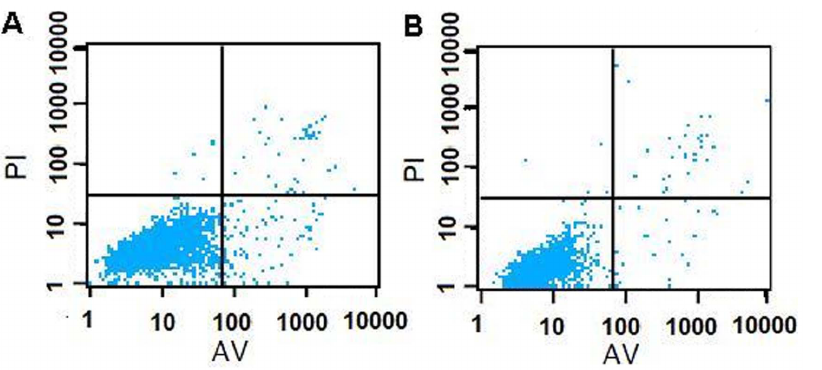
Figure 8. Flow cytometric apoptotic analysis. (A) MCF-7 cells and (B) MCF-7 cells transfected with probe loaded complex at 37 u C for 3 h.